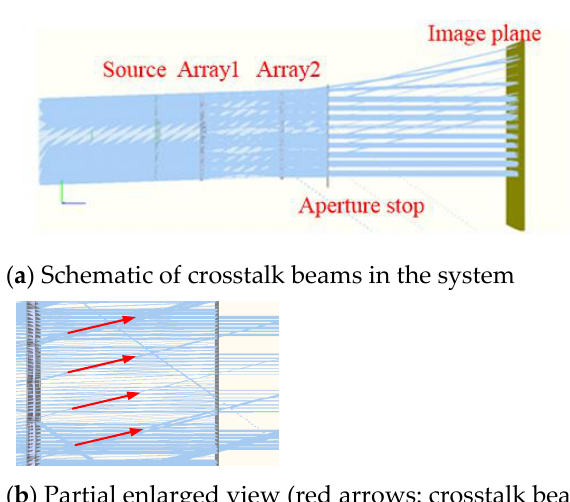
Figure 12. FRED simulation of crosstalk phenomenon in the microlens array.